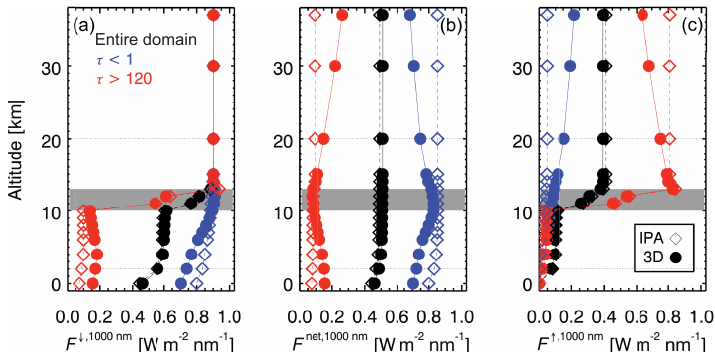
Figure 4. Profiles of (a) downwelling, (b) net, and (c) upwelling irradiance at 1000nm for the cloud field from Fig. 1. The location of the cloud layer is marked in gray. Both IPA (dashed line, hollow symbols) and 3-D calculations (solid line, full symbols) are shown, averaged over the full domain (black), over all columns with τ <1 (blue), and over columns with τ >120